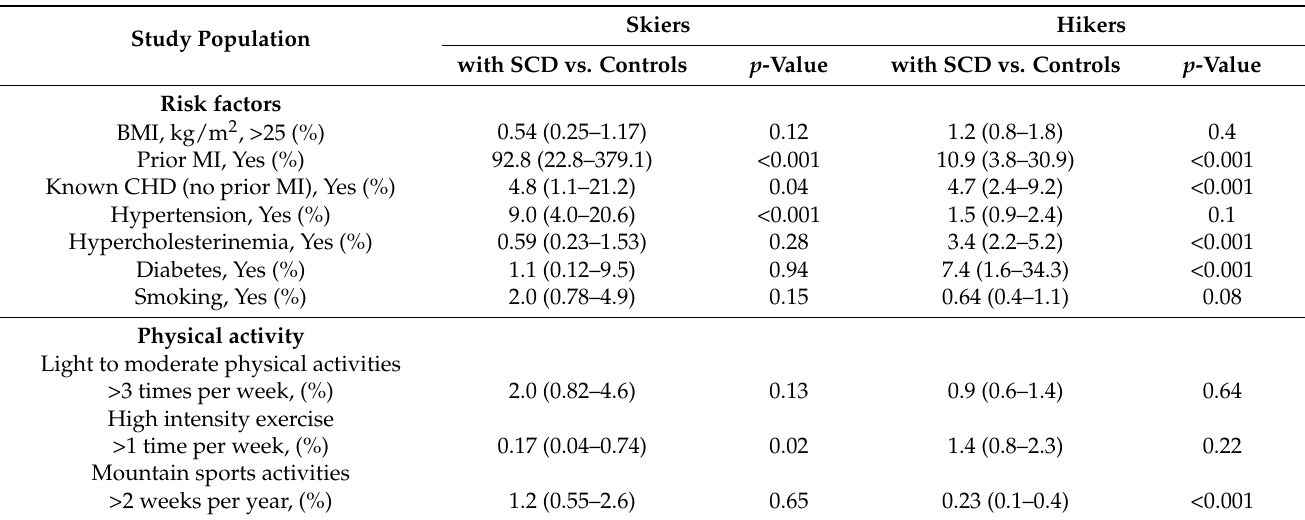
Table 2. Comparison of adjusted odds ratios (95% confidence intervals) with regard to risk factors and physical activity habits among SCD victims and Controls derived from logistic regression